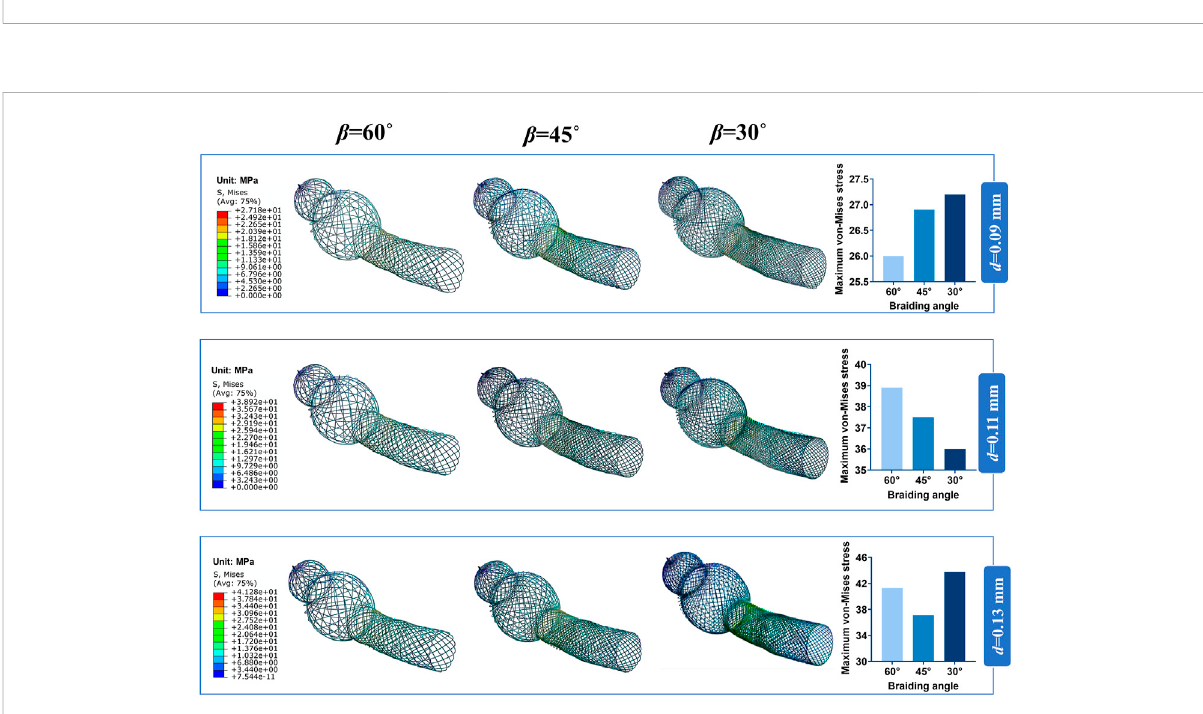
FIGURE 8 Contour plots of von-Mises Stress of the bended nasal stent: Stent model